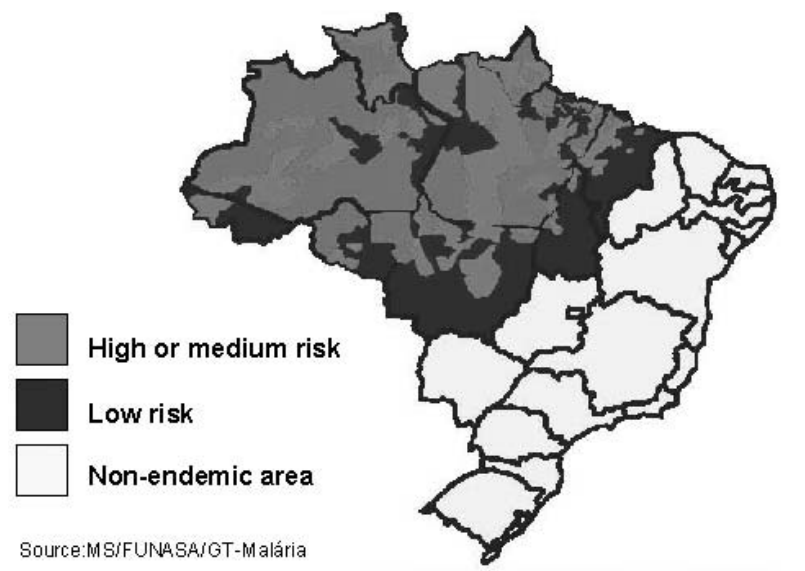
Fig. 1 – Malaria risk areas in Brazil.